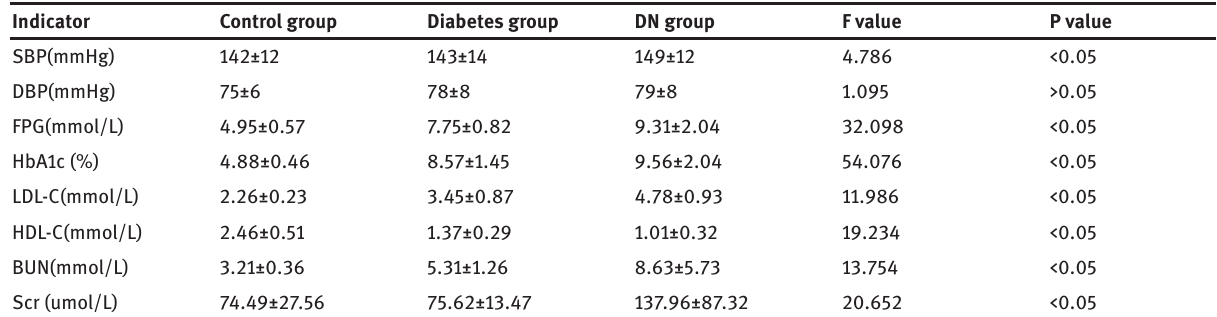
Table 1: Comparison of basic indicators between the patients in three groups.